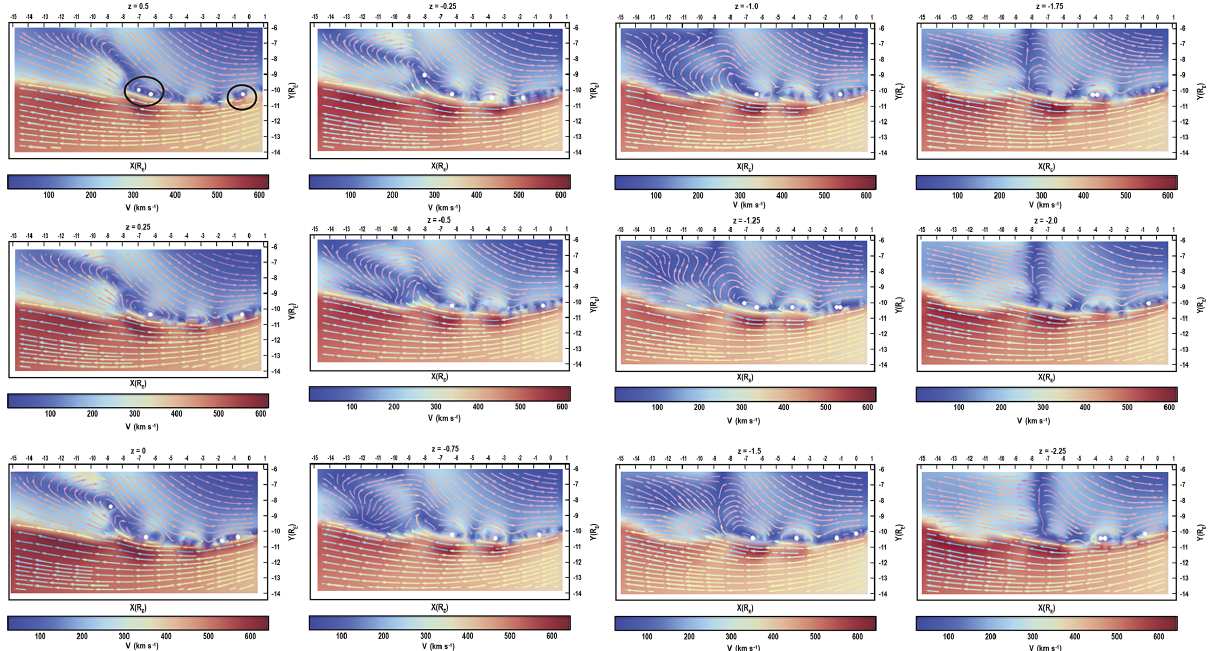
Figure 8. The extension along the Z axis of the vortices and FTE presented in the time step of 02:18UTC. The velocity magnitude is represented by the background color and streamlines are represented by arrows (left to right). The Kelvin–Helmholtz vortex and FTE are emphasized in the first panel by black circles. The white dots represent the center of the vortices as found by our algorithm. The FTE is still visible at Z = − 2 . 25 R E , whereas the Kelvin–Helmholtz vortex center is last seen at Z = − 1 . 5 R E